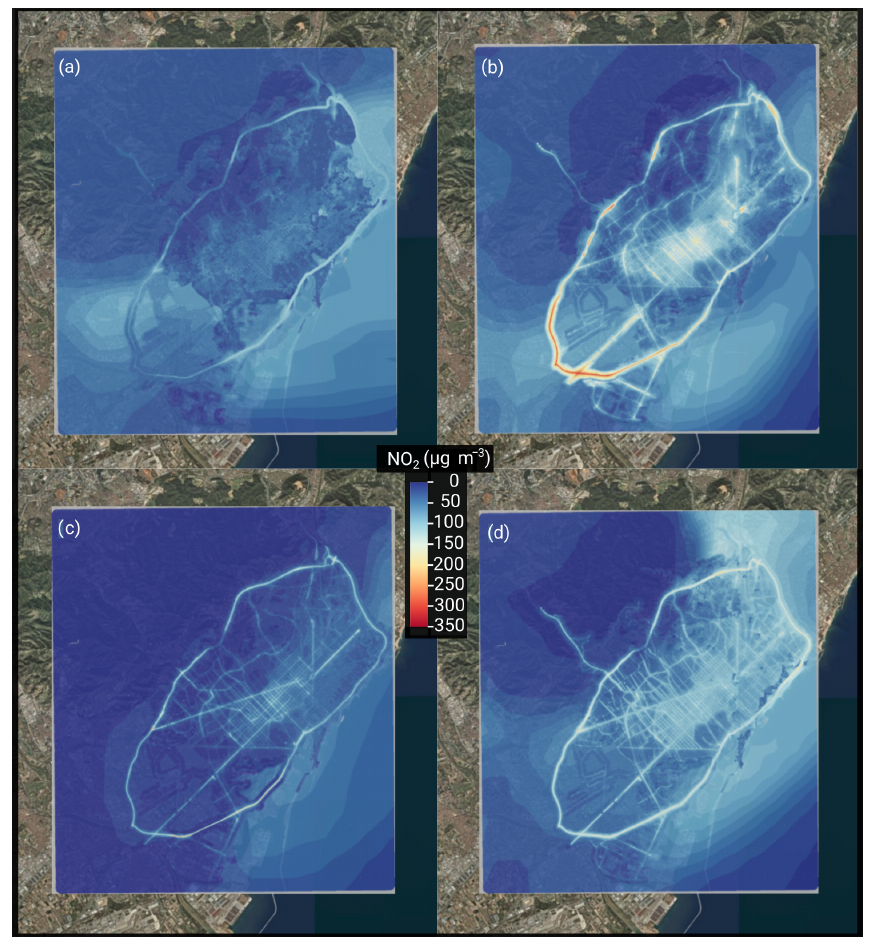
Figure 12. NO 2 high-resolution (10m × 10m) concentration maps on 11 April 2013. The resolution is for the entire concentration map. Panel (a) represents concentrations at 00:00UTC (2:00LT), (b) 07:00UTC (9:00LT), (c) 12:00UTC (14:00LT) and (d) 18:00UTC (20:00LT). Basemap source: Esri